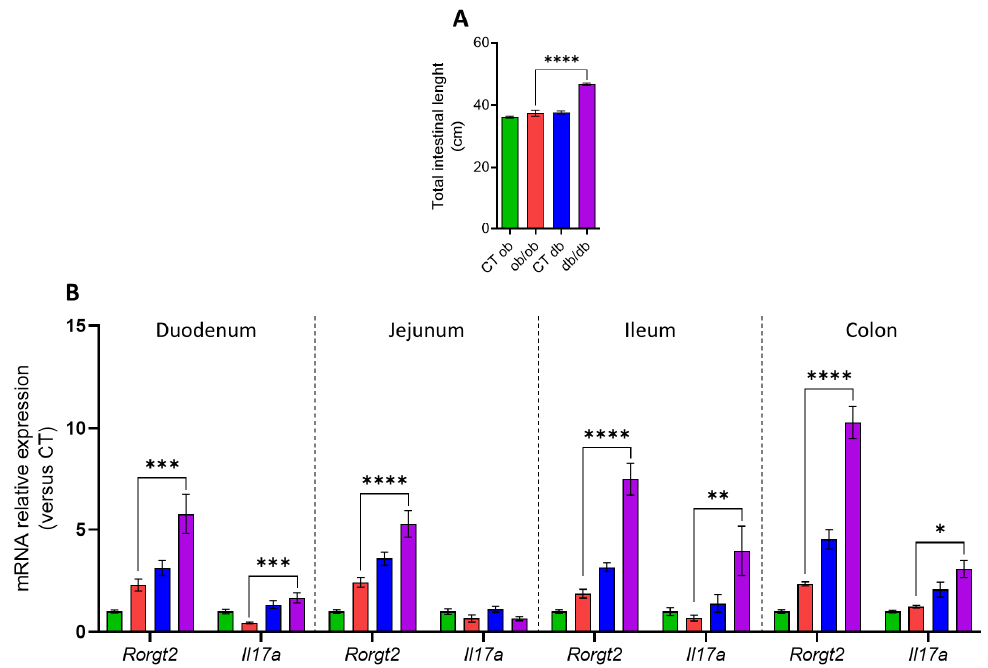
Figure 1. Distinct intestinal length and inflammatory profile in ob/ob and db/db mice. ( A ) Total intes ‐ tinal length measured at necropsy (cm) ( n = 7–8). ( B ) mRNA expression of pro ‐ inflammatory mark ‐ *** p ≤ 0.005, **** p ≤ 0.001. For mRNA expression, relative units were calculated versus the mean